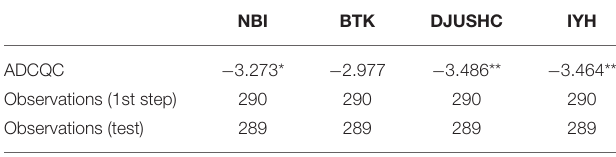
TABLE 6 | Engle-Granger cointegration tests results.